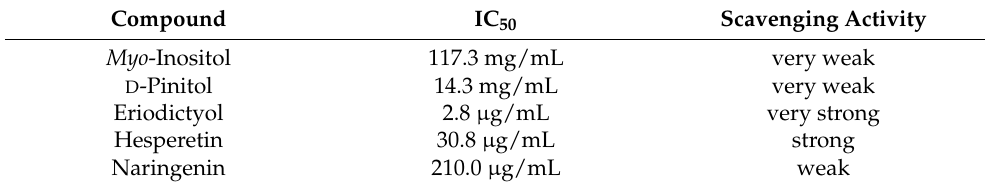
Table 2. The IC 50 values for selected cyclitols, flavanones, and glutathione.